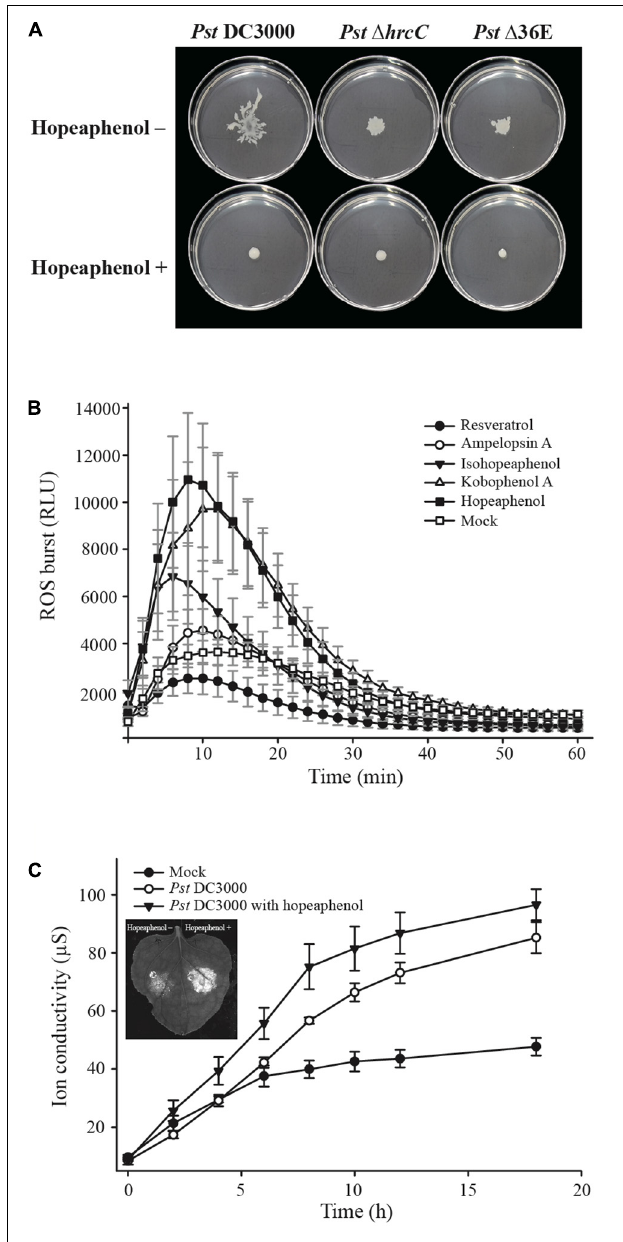
FIGURE 1 | Resveratrol compounds regulate bacterial motility, ROS production, and induction of cell death response. (A) Bacterial motility upon hopeaphenol treatment. The Pst DC3000 wild-type strain, the hrcC deletion mutant ( Pst (cid:49) hrcC ), and a mutant lacking 36 effector genes ( Pst (cid:49) 36E) fail to swarm on the surface of a medium containing hopeaphenol. Tendril patterns and migrating distance were observed 48 h after inoculation. (B) ROS burst in Arabidopsis in response to pre-treatment with resveratrol compounds. Arabidopsis leaves were pre-treated with five different resveratrol derivatives at a concentration of 100 µ M, 19 h before exposure to PAMP. ROS production was measured with a luminometer every 2 min for 1 h. (C) Cell death induction in N. benthamiana leaves. Hopeaphenol was applied to N. benthamiana leaves 16 h before infection. The ion conductivity of the leaves infected by Pst DC3000 (1 × 10 6 cfu/ml) was measured 40 h after infection. The picture on the left of the graph showed induced cell death